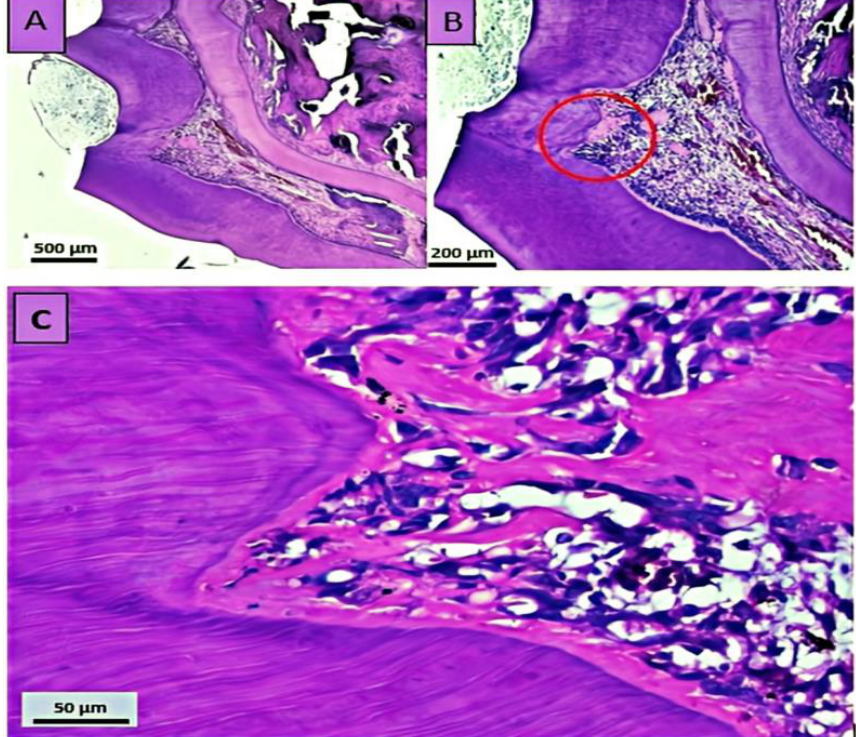
Figure 3. ( A – C ) (4×, 10× and 40×): Microscopic view of c-GIC occlusal restoration showing Grade 1 pulp tissue disorganization after 1 week of interventional period in the area encircled as red in ( B ) (H&E).